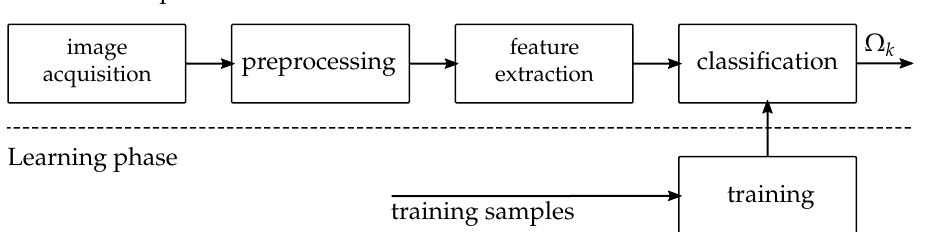
Figure 7. The Pattern Recognition Pipeline: From the original image to the classified result (adapted from